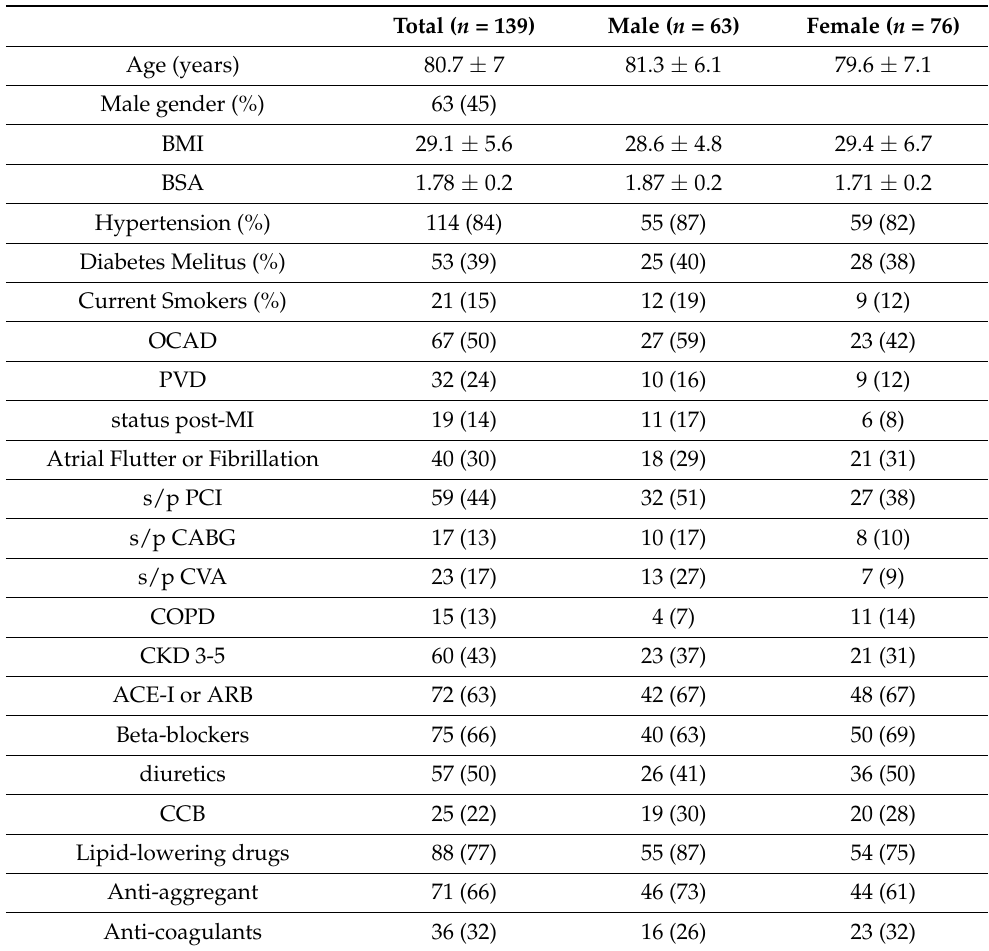
Table 1. Baseline